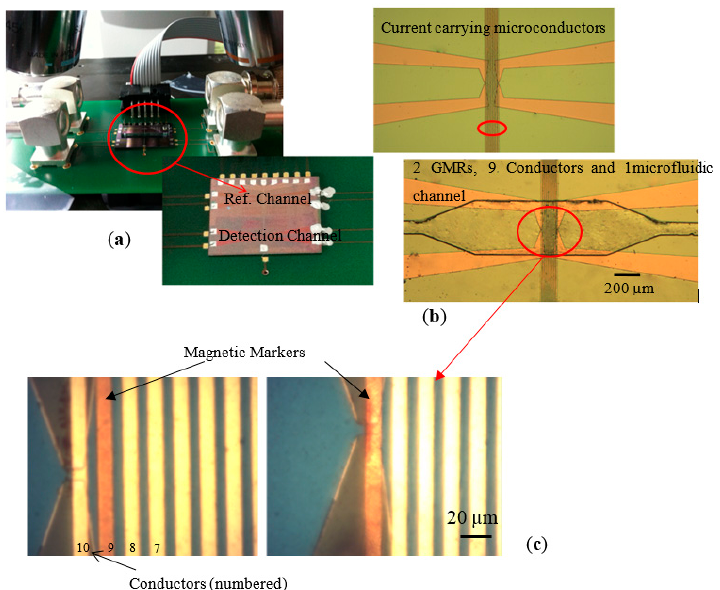
Figure 2. ( a ) The developed biosensor that consists of the giant magnetoresistance (GMR) sensors, the microconductors and the microfluidic channels; ( b ) Microscope image of the microconductors and a microfluidic channel; ( c ) Detailed image of the microconductors and the GMR sensor with magnetic markers as they moved from the right to the left microconductor.